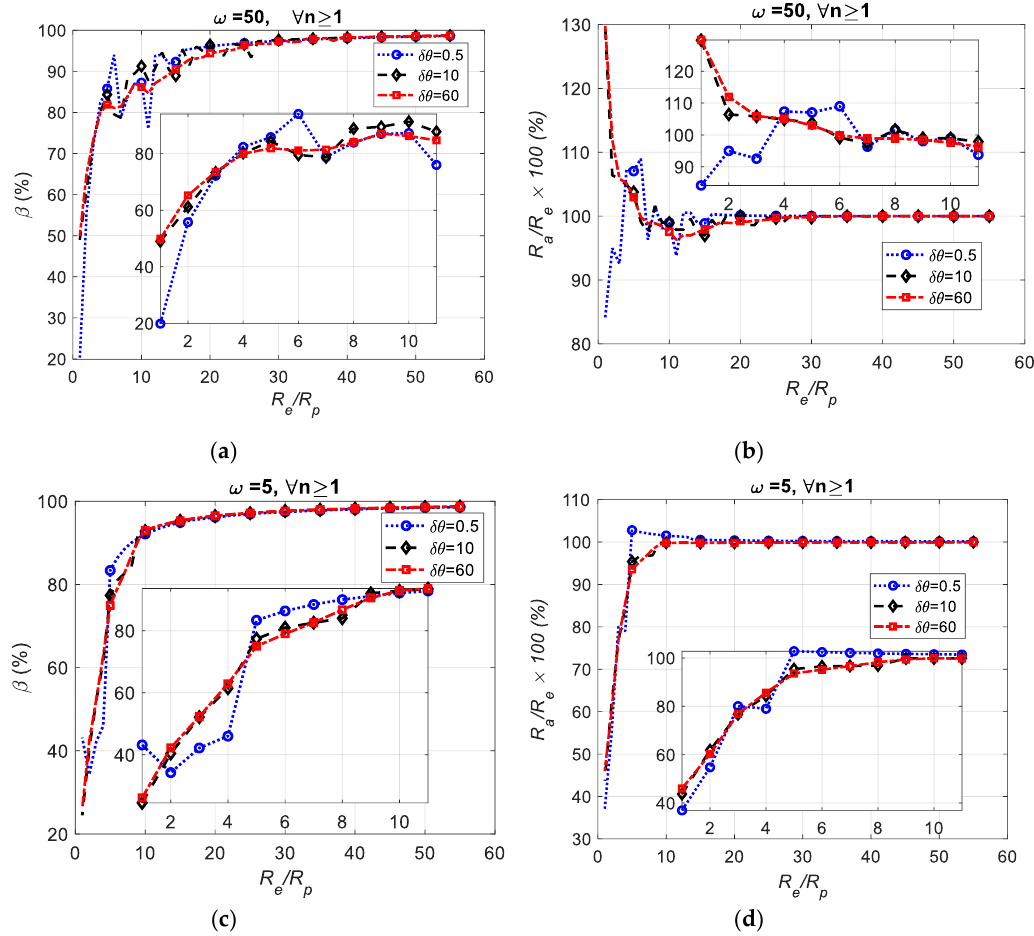
Figure 10. Exponential responses of the roundness index β simulated for the sampling increment θ , ratio of nominal radius to fluctuation amplitude R e /R p , and fluctuation frequency ω . ( a ) Roundness index vs. fluctuation ratio at frequency 50 rad / s. ( b ) Exact radius to nominal radius ratio vs. fluctuation ratio at frequency 50 rad / s. ( c ) Roundness index vs. fluctuation amplitude at frequency 5 rad / s. ( d ) Exact radius to nominal radius ratio vs. fluctuation amplitude at frequency 5 rad /